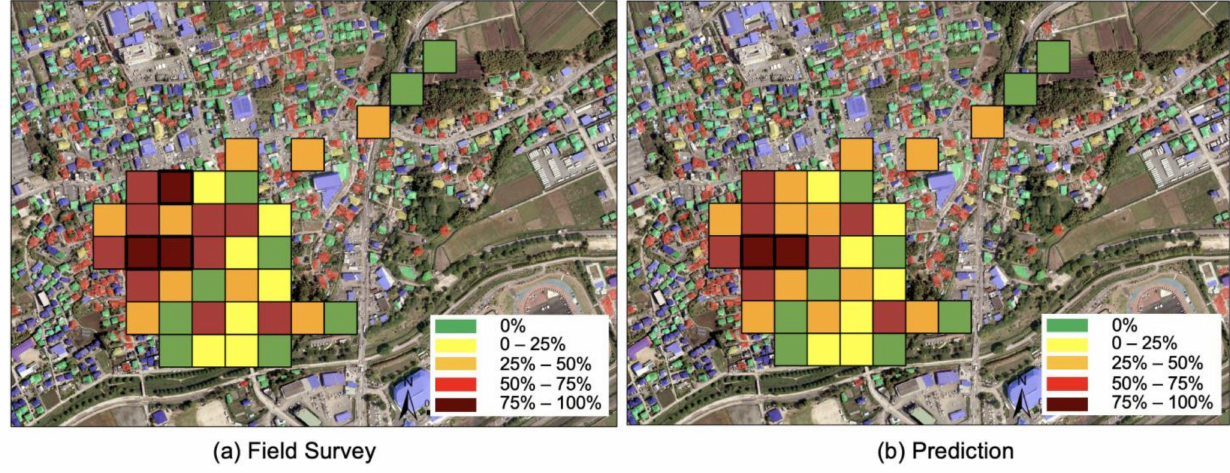
Figure 14. Close-up of the comparison of the field survey and our prediction for the grids containing only the test